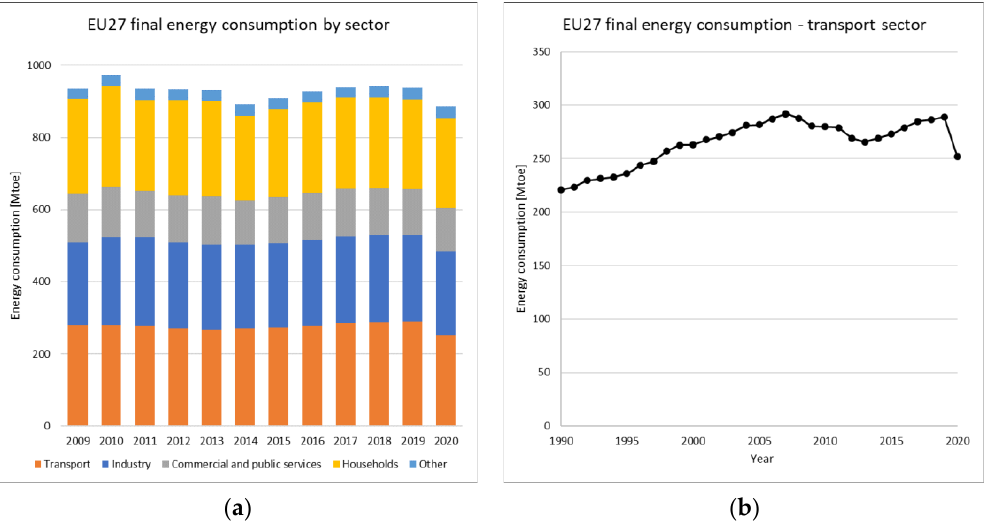
Figure 1. EU27 energy consumption by sector and focus on the last 30 years of transport.